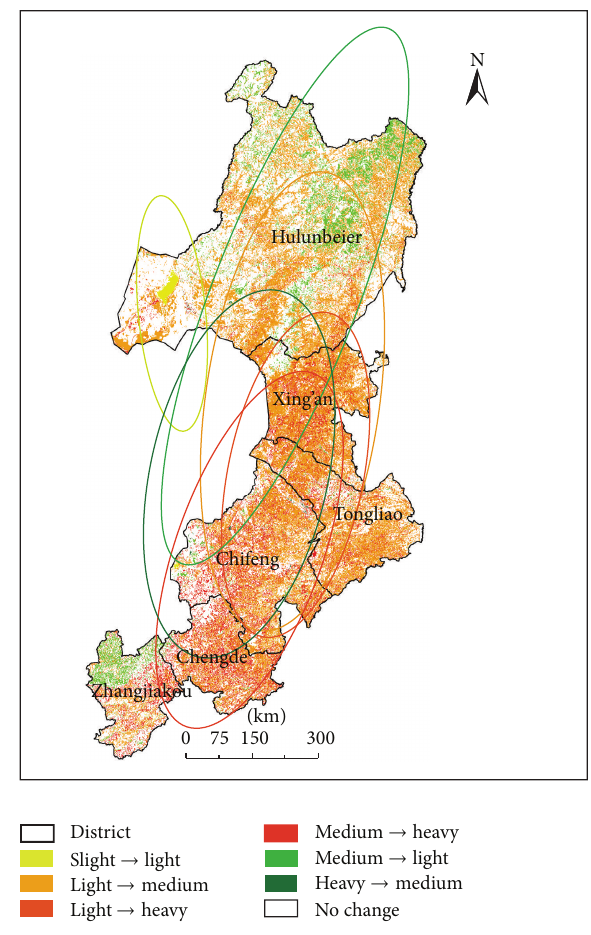
Figure 5: Spatial distribution of ecological vulnerability